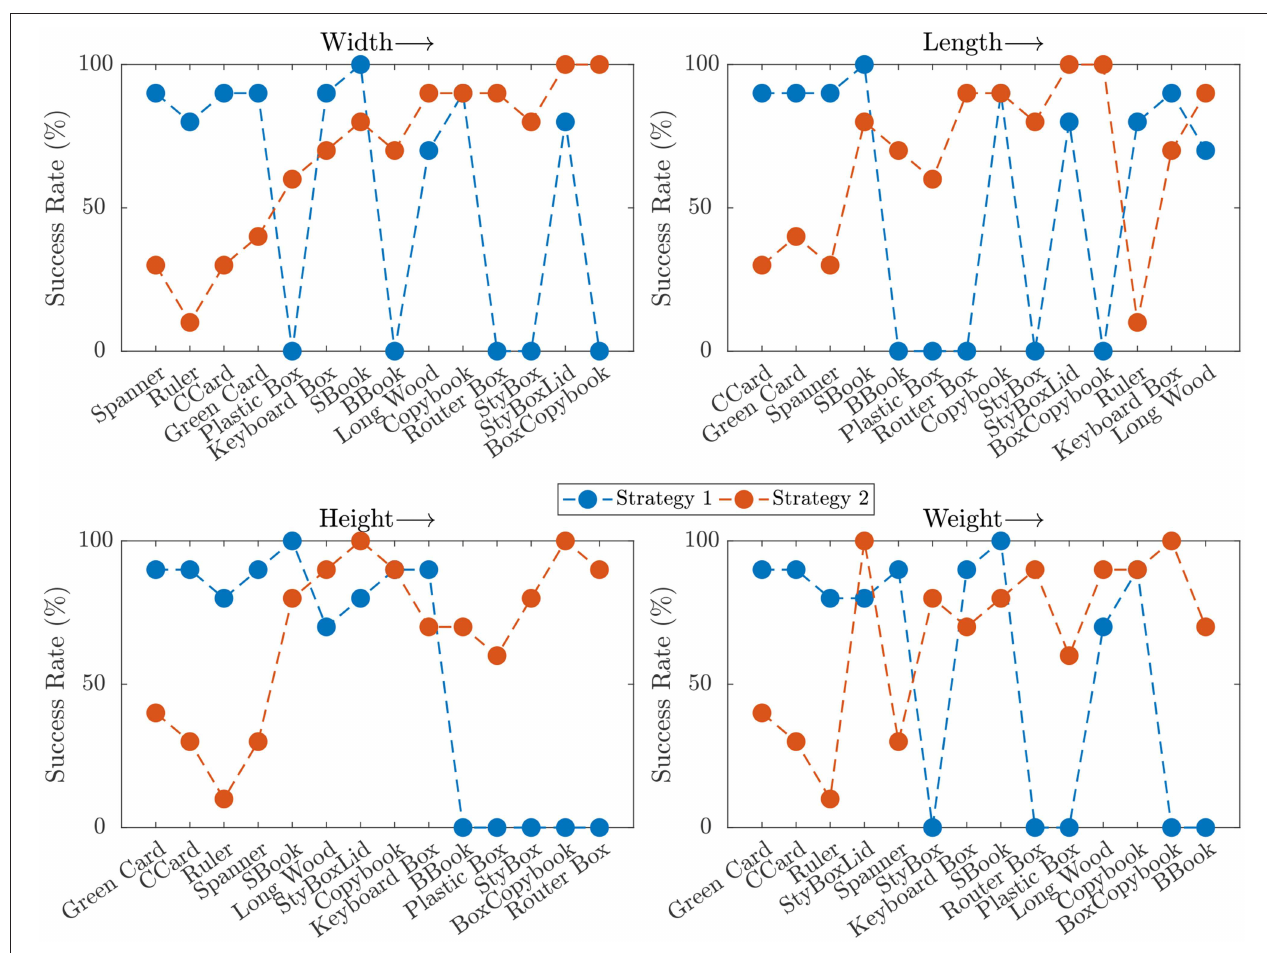
FIGURE 12 | Success rate for different objects for each of the considered features, sorted in ascending